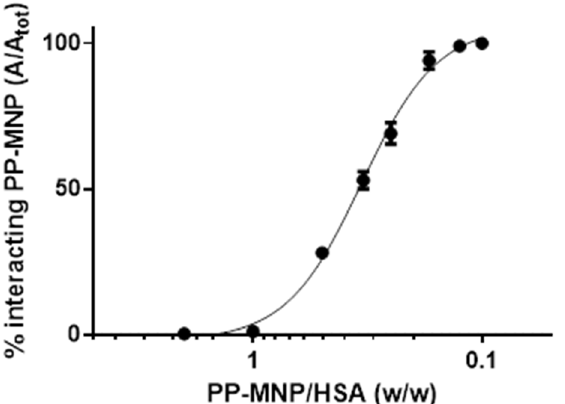
Figure 8. HSA/PP-MNP interaction vs. HSA increase expressed as the percentage of PP-MNPs in- teracting with HSA (black dots and error bars, n = 3) calculated from independent runs of supensions at 2:1, 1:1, 1:2, 1:4, 1:6, 1:8, 1:10 PP-MNPs:HSA mass ratio.